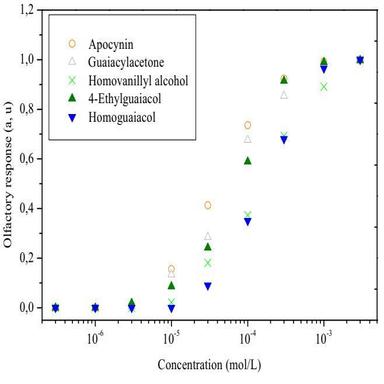
Concentration-olfactory response curves of the mouse eugenol olfactory receptor mOR-EG activated by apocynin, guaiacylacetone, homovanillyl alcohol, 4-ethylguaiacol, homoguaiacol odorants.